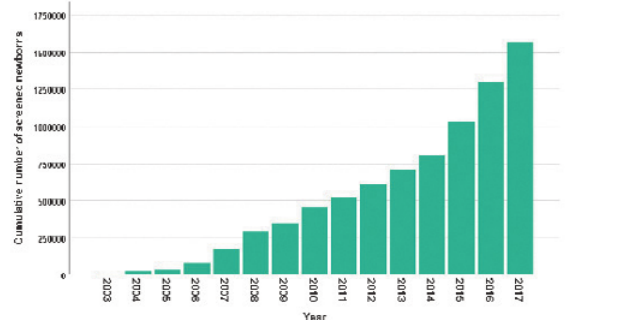
Figure 1: Cumulative number of newborns screened for fabry disease